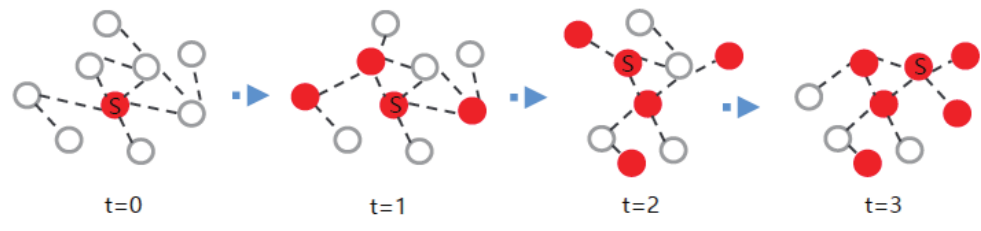
Figure 1. Example of movement of information source over dynamic network. (Red: infected node, S: